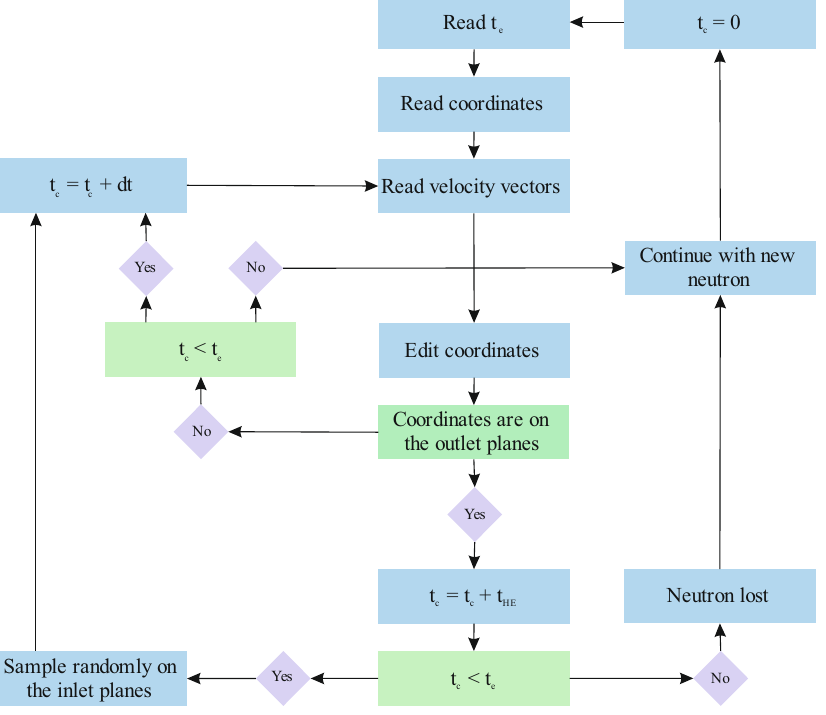
Figure 3.1. SERPENT extension